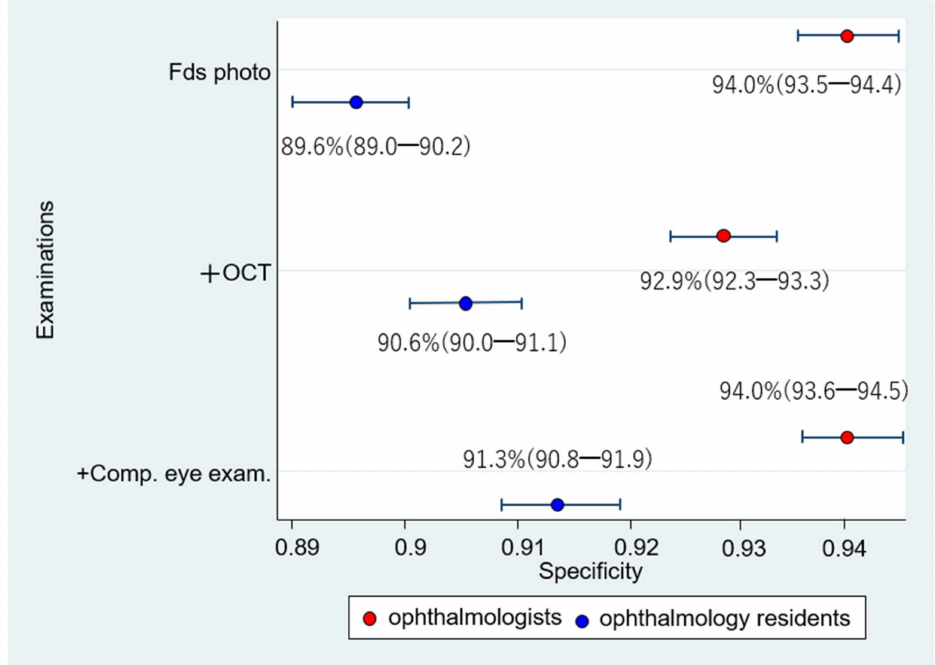
Figure 8. Specificity for diagnosis by ophthalmologists and ophthalmology residents. Comparing the specificity between the ophthalmologists and ophthalmology residents, the specificity of ophthalmol- ogists is significantly higher for fundus photography alone, fundus photography + OCT, and fundus photography + OCT + comprehensive exam than that for ophthalmology